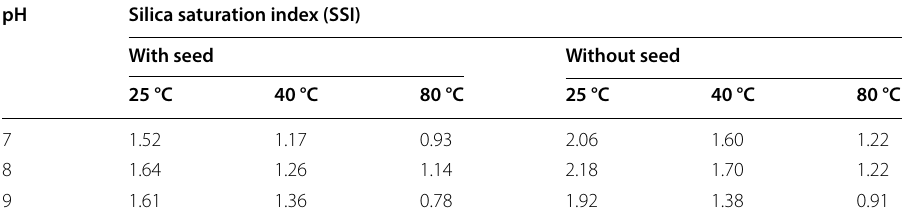
Table 3 Silica Saturation Index (SSI) with and without seed addition pH Silica saturation index (SSI) With